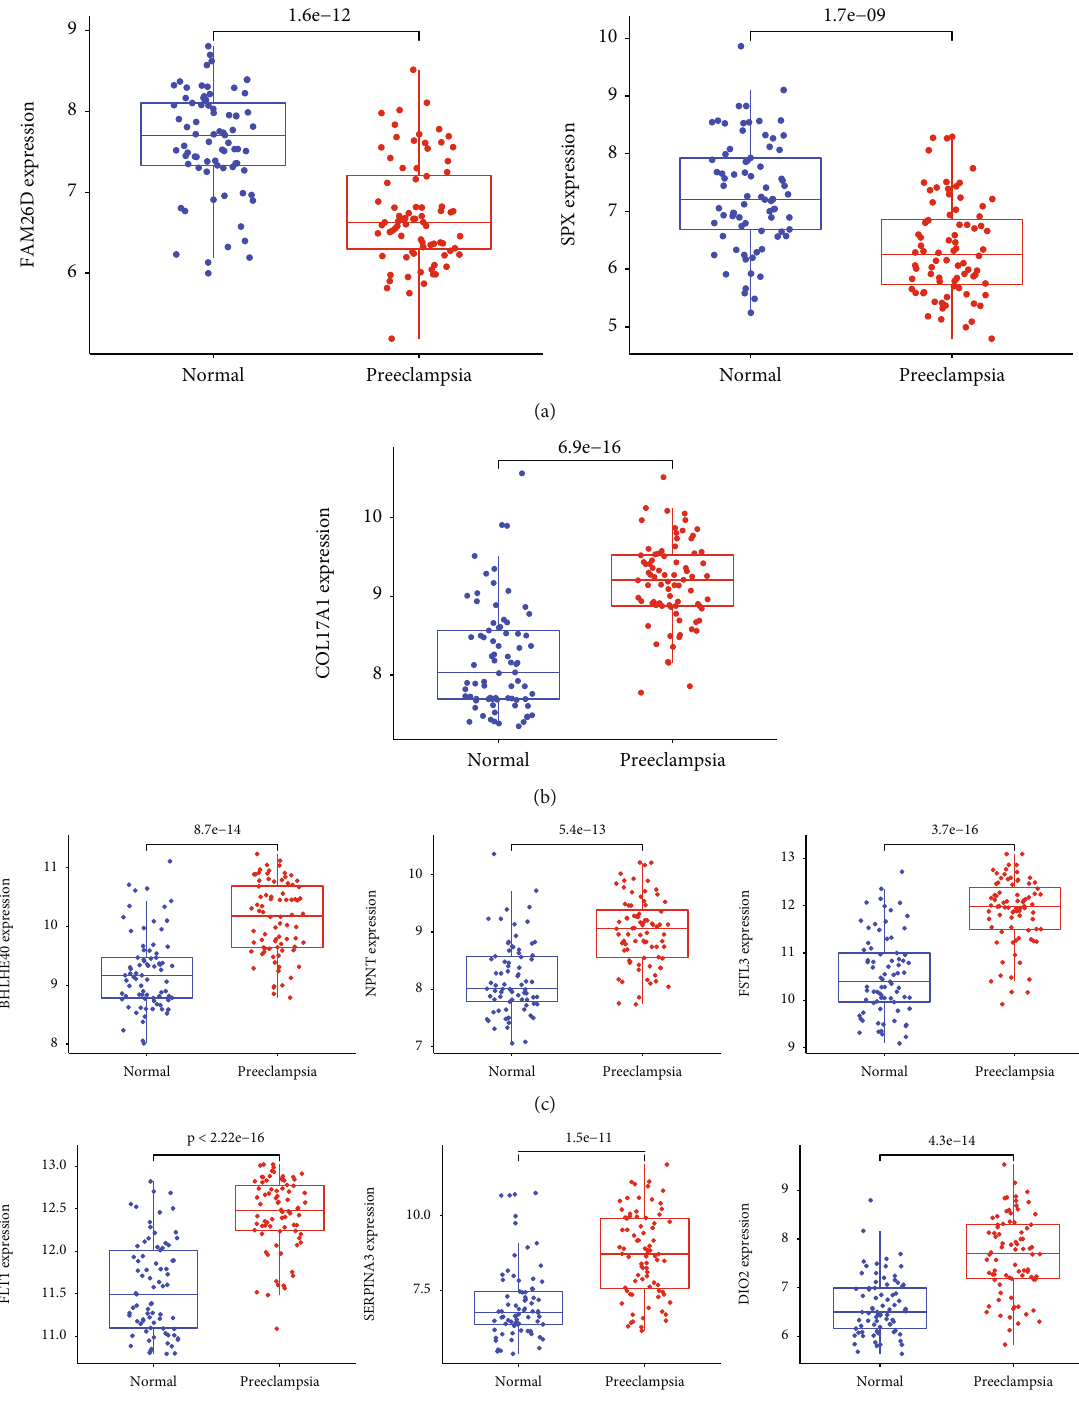
Figure 4: The expression pattern of the 9 critical genes in preeclampsia. (a) FAM26D and SPX were lowly expressed in preeclampsia. (b – d) FLT1, FSTL3, COL17A1, DIO2, BHLHE40, NPNT, and SERPINA3 were highly expressed in